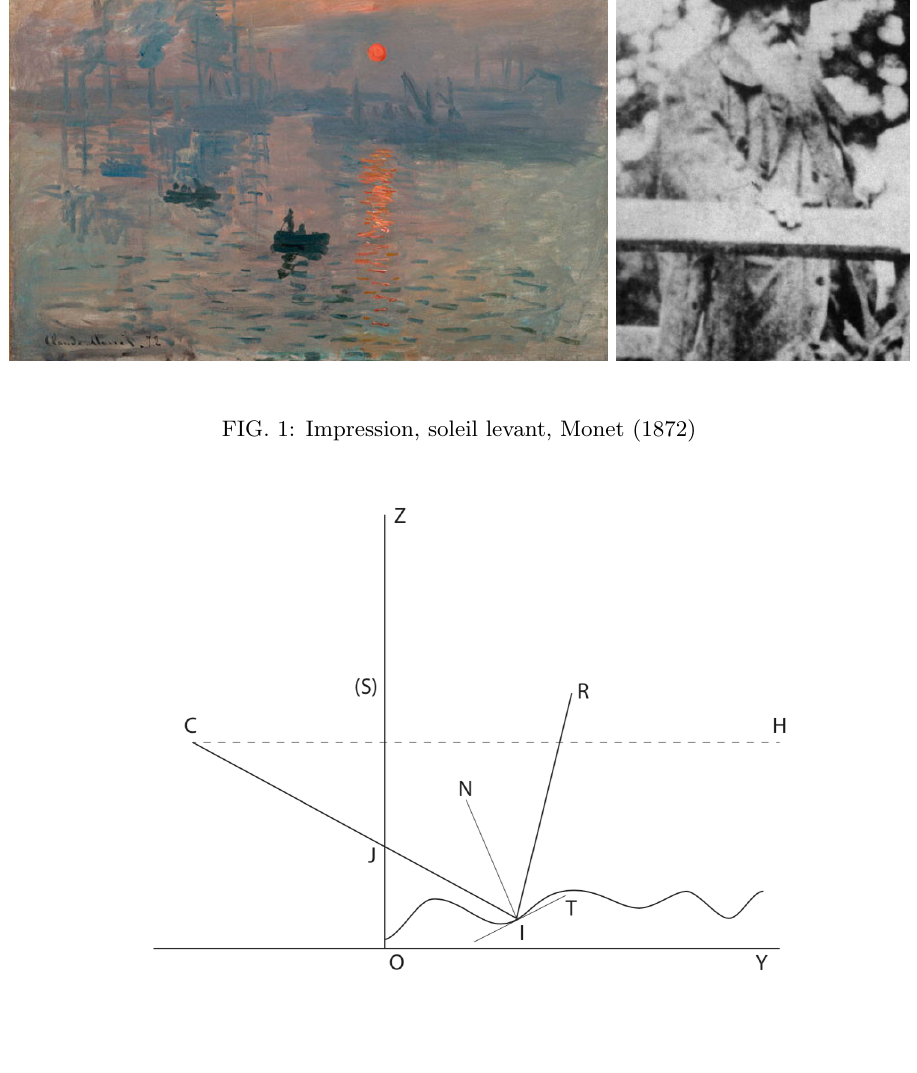
FIG. 2: This figure is to explain the ray tracing algorithm used for numerical simulations. A cross section is displayed, such as the sea surface is in the plane z = 0. It crosses the shore on the line y = z = 0. A screen is put in the plane y = 0. From a point C a ray is sent that crosses the reflecting sea surface at I . One compute then the direction of the reflected ray in the solid angle of the Sun seen from I , one points a point J of a different color than the background. In the simulation to get rid of effects of discrete representation of the surface the sea is represented by a set of tiny mirrors whose normal are taken randomly between two